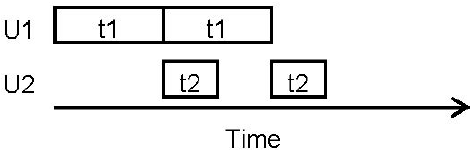
Figure 2. Schedule with zero transfer times.